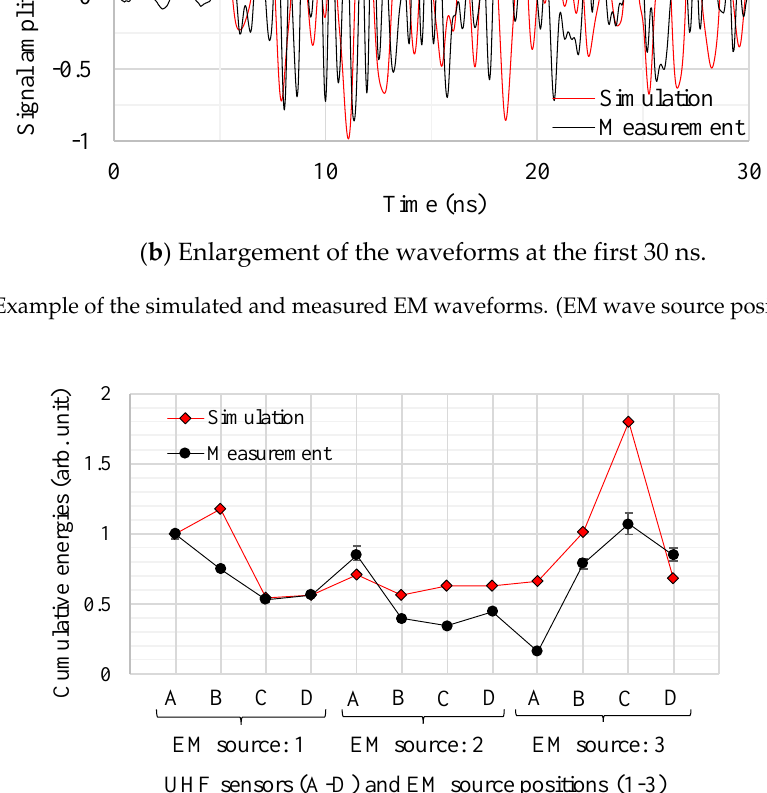
Figure 15. Simulated and measured signal amplitudes for each UHF sensors and EM wave source. 5. Conclusions The authors have proposed a simulation technique for EM wave propagation within transformers and validated the simulated results by comparing with those experimentally obtained, using a 630 kVA distribution transformer. First, validities of modeling methods for a monopole antenna as an EM wave source, UHF sensors as well as the transformer tank were investigated by comparing with experimental results obtained with an empty transformer tank. Consequently, the simulated time-domain EM waveforms, the attenuation rate of EM wave strengths and cumulative energies as a function of UHF sensor position showed good agreement with the measured ones. Therefore, those modeling methods were successfully validated. Second, propagation times, signal amplitudes and cumulative energies of the EM waves were evaluated by simulation, measurement and theoretical consideration by using a 630 kVA distribution transformer in order to confirm the validation of the modeling of the active parts of a transformer. As a result, the simulated EM waveforms, their propagation times, cumulative energies and signal amplitudes as a function of UHF sensor position showed reasonable agreement with the experimentally and theoretically obtained ones. This suggests that the computational conditions, including the modeling of the transformer structure were appropriate. Based on these results, this newly developed simulation technique, proposed in this paper, will contribute to the optimization of the UHF sensor positions and their numbers as well as the type of UHF sensors to obtain the desired PD detection sensitivity for power transformers.